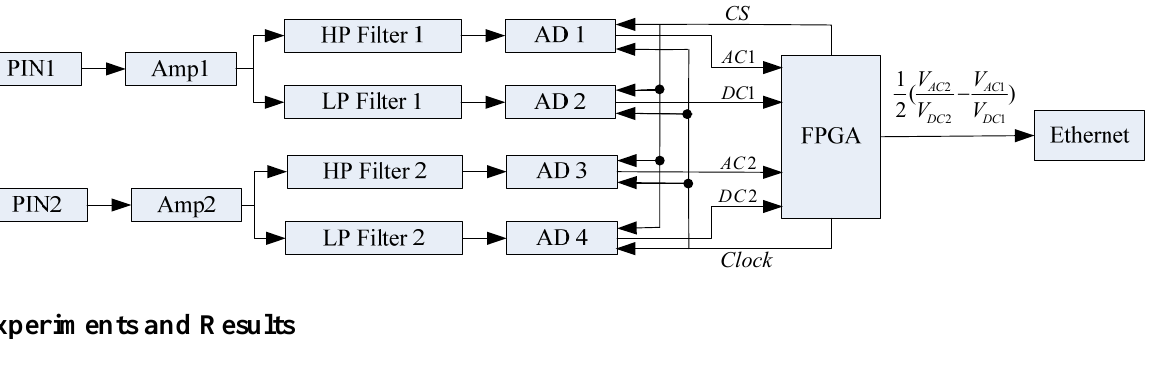
Figure 3. Block diagram of the signal processing